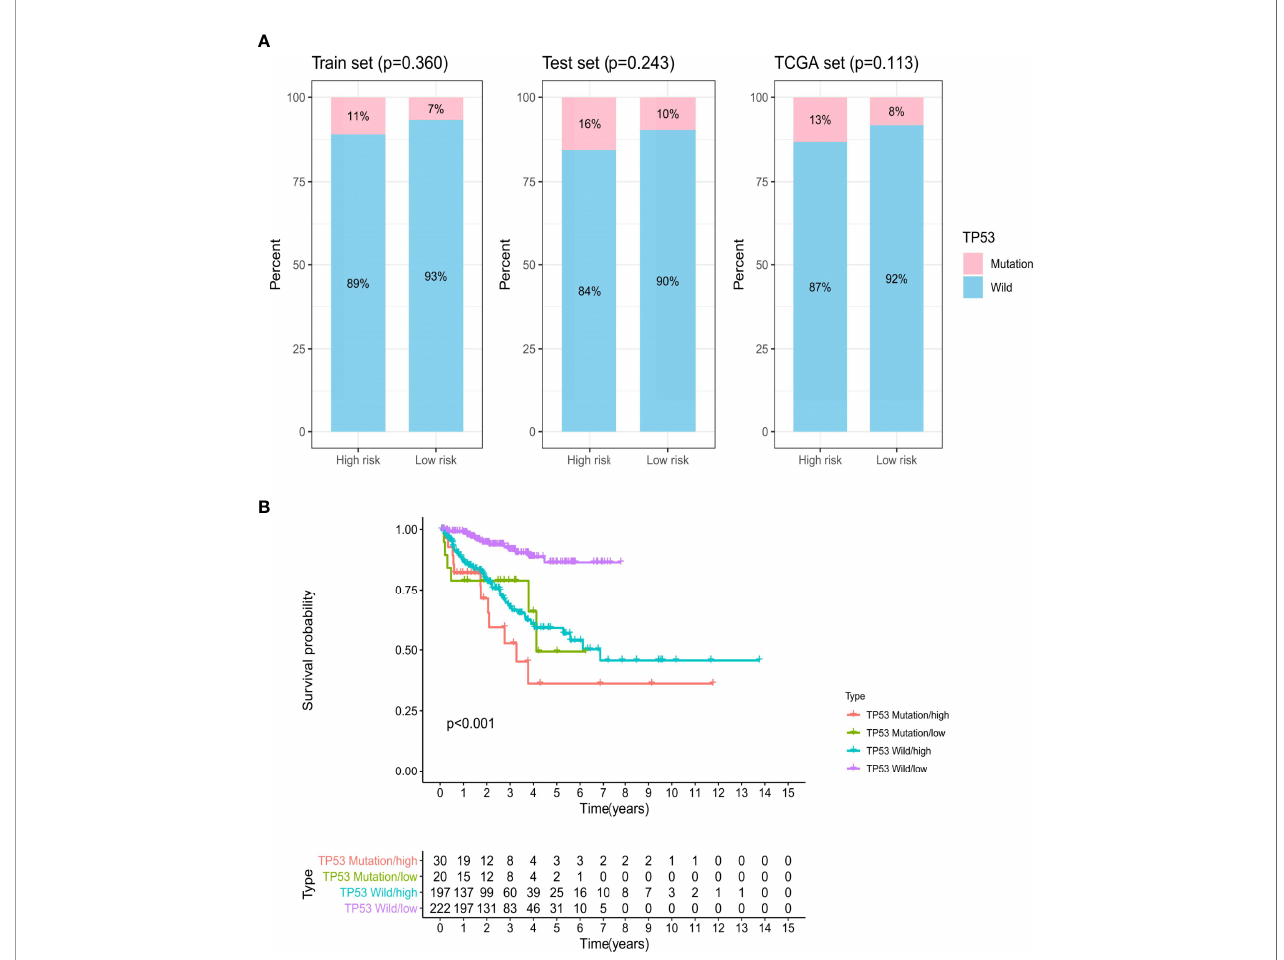
FIGURE 7 | The biochemical recurrence model combined with GILncSig and TP53 mutation status. (A) The proportion of TP53 mutation in the high- and low-risk groups in the train set, test set, and TCGA set. (B) Kaplan – Meier curve analysis of biochemical recurrence is shown for patients strati fi ed based on TP53 mutation status and the